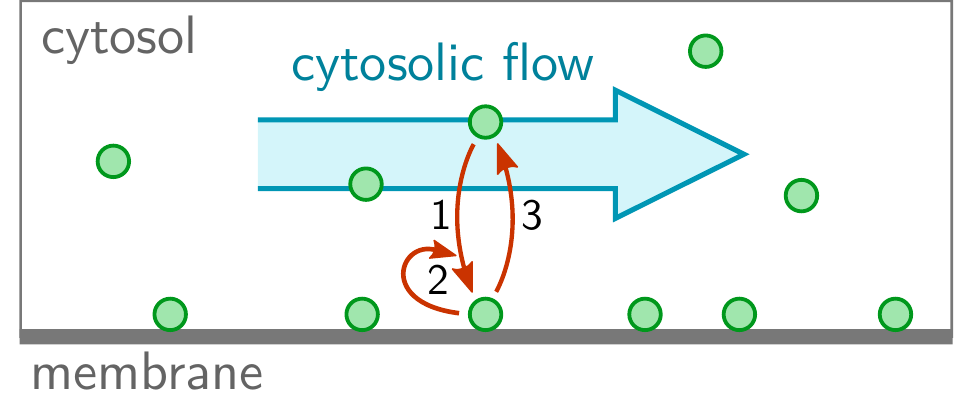
Figure 1. One-dimensional two-component system with cytosolic flow into the positive x -direction. The reaction kinetics include ( 1 ) attachment, ( 2 ) self-recruitment, and ( 3 ) enzyme-driven